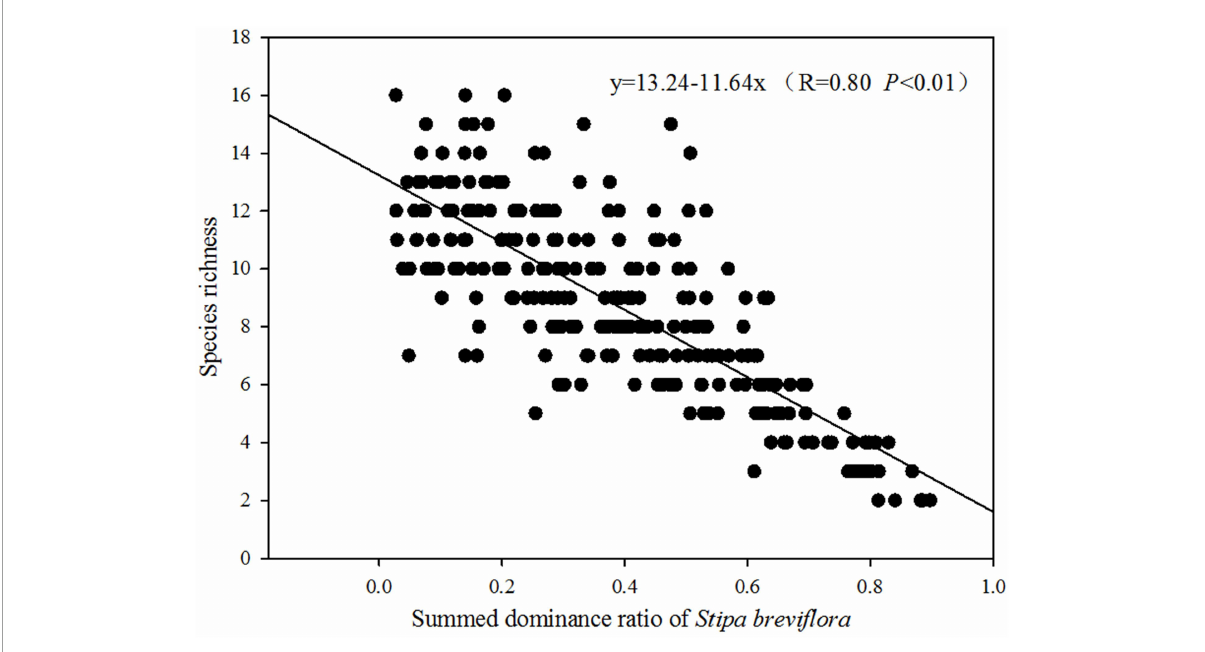
FIGURE2 Regression fitting analysis of species richness and summed dominance ratio (SDR) of Stipa breviflora .